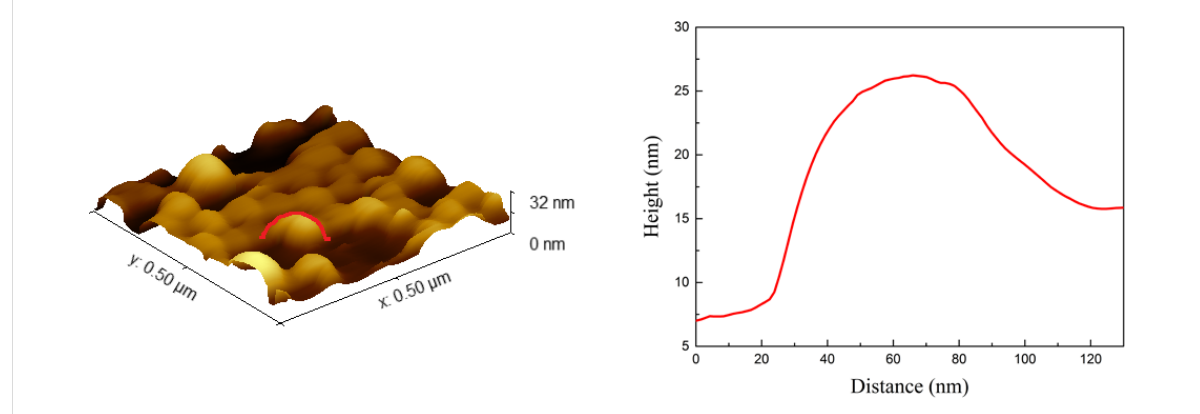
Figure 6: Left: AFM image of a 2.8 nm Au film on a Si(111) substrate annealed at 550 °C for 15 min; right: cross section of a selected nanoisland.